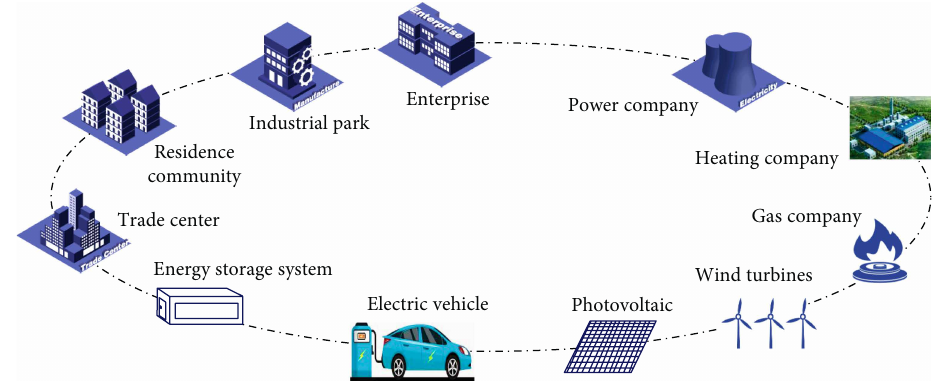
Figure 1: Open interconnection of multienergy